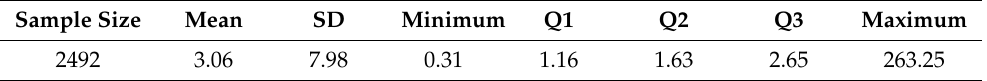
Table 2. Summary statistics, for Danish fire insurance data (in 1 million